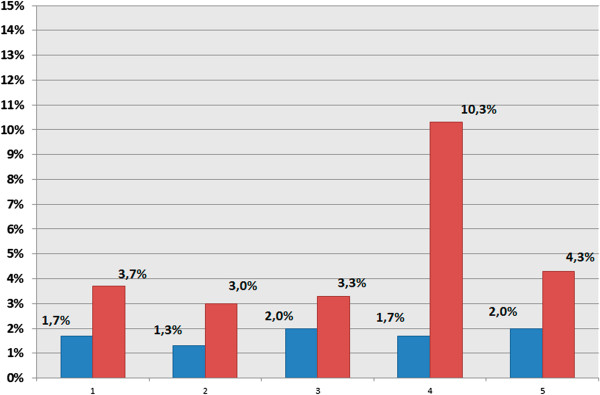
X chromosome aneuploidy in the hippocampus of the AD brain and controls analyzed by ICS-MCB (AD: n = 5, red bars; control: n = 5, blue bars); AD: mean 4.92%, 95% CI 1.14-8.71; control: mean 1.74%, 95% CI 1.38-2.1; X axis: number of samples’ pairs: AD patient—age-matched control; Y axis: rates of aneuploidy (given in %).